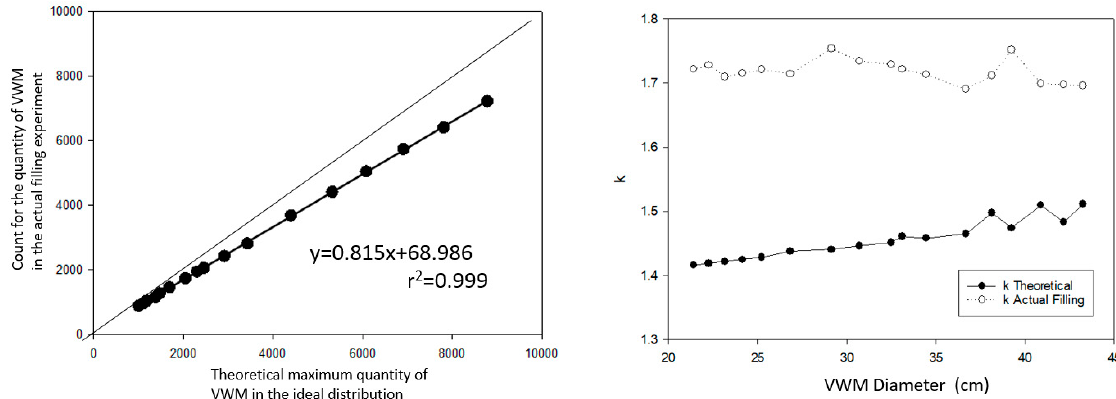
Figure 10. The mathematical relationship between the theoretical maximum and actual filling of VMWs. ( Left ): There is a simple linear relationship with the theoretical and the actual (r 2 = 0.999); ( Right ): The theoretical and empirical k determined by Equations (5) and (6).